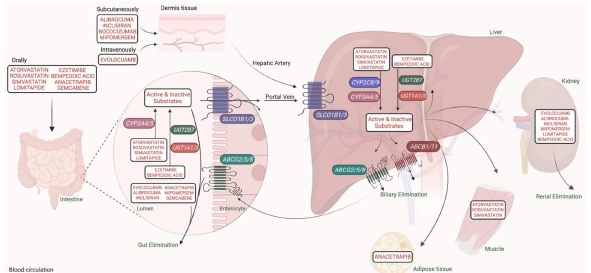
Figure 2. A schematic representation of the pharmacokinetic modulator genes involved in absorption, distribution, metabolism, and clearance of lipid-lowering therapy (created with